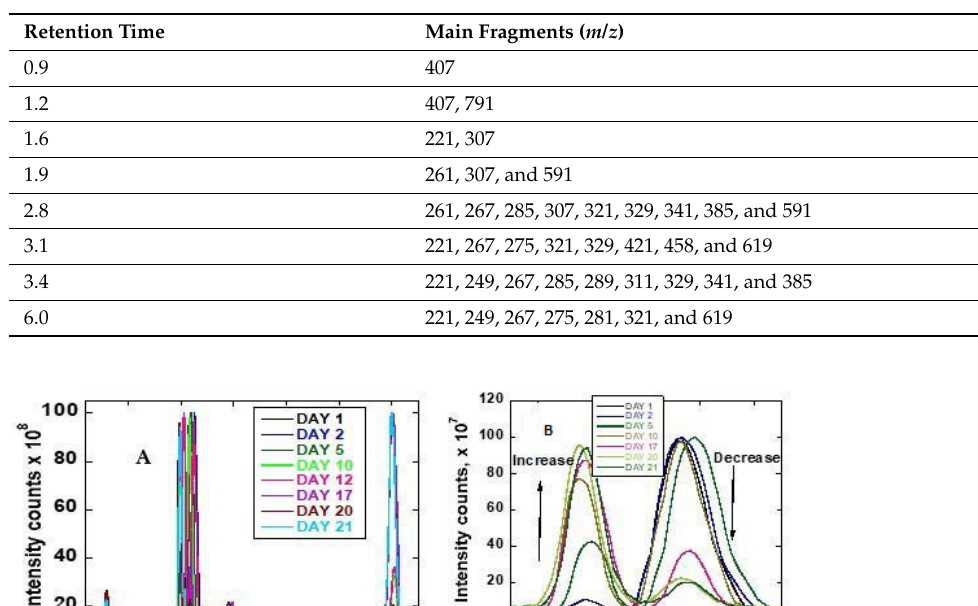
Table 1. Retention time and fragmentation patterns of ARTS reaction products in methanol.